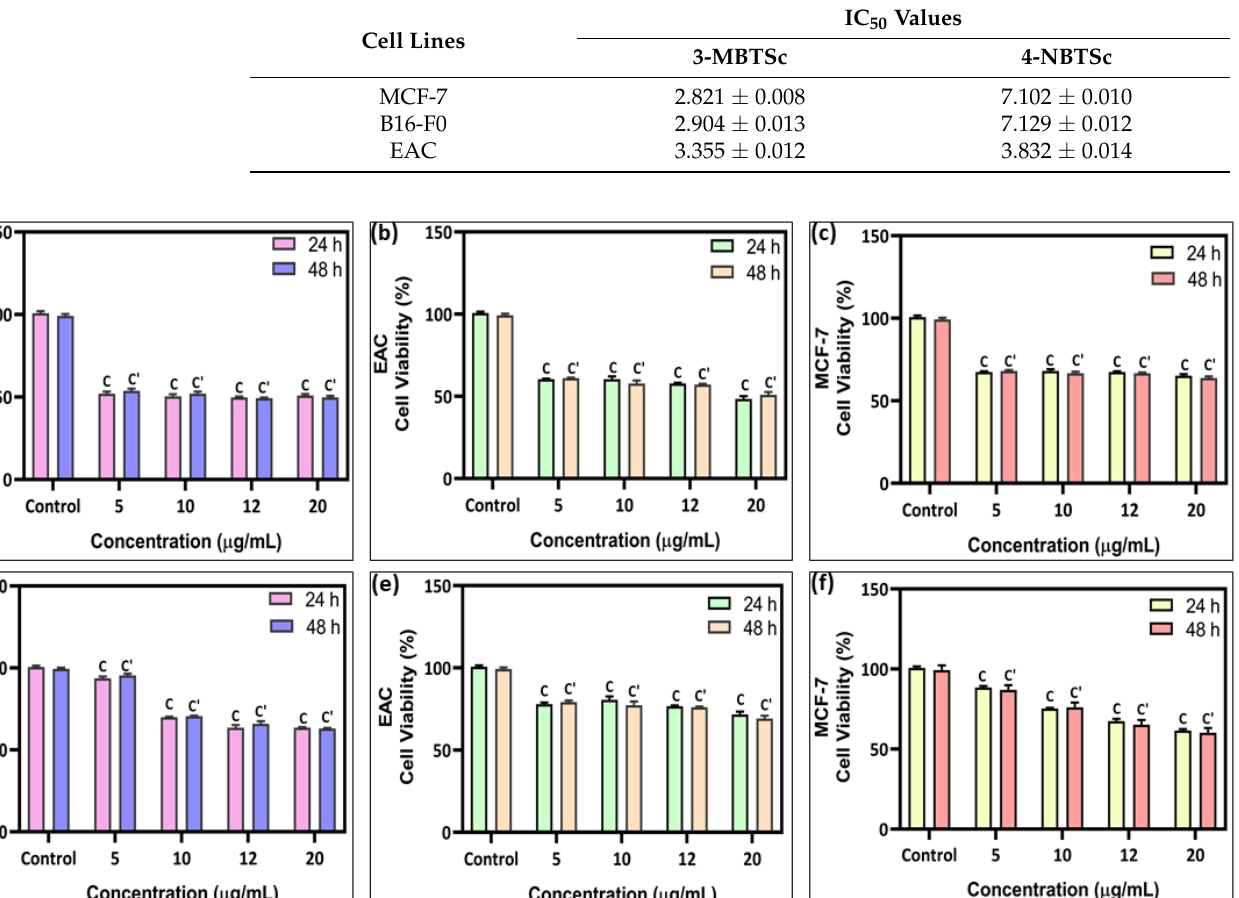
Figure 3. FTIR spectra of 3-MBTSc and 4-NBTSc compounds in the wavenumber range of 600-4000 cm − 1 .